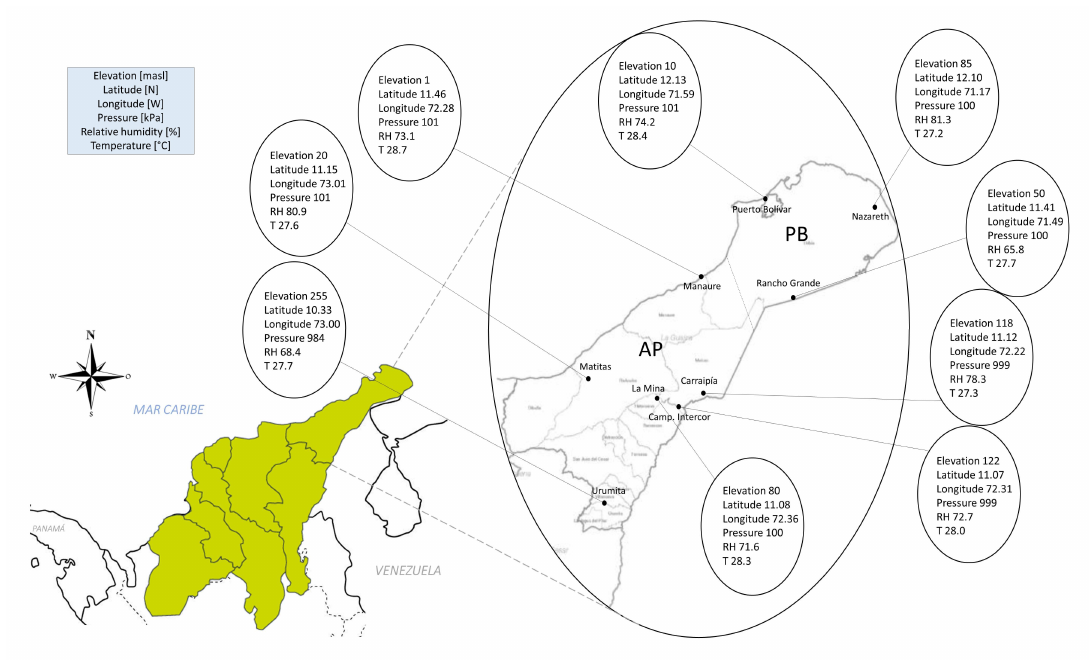
Figure 2. Geographic locations of the di ff erent meteorological stations in La Guajira, Colombia.